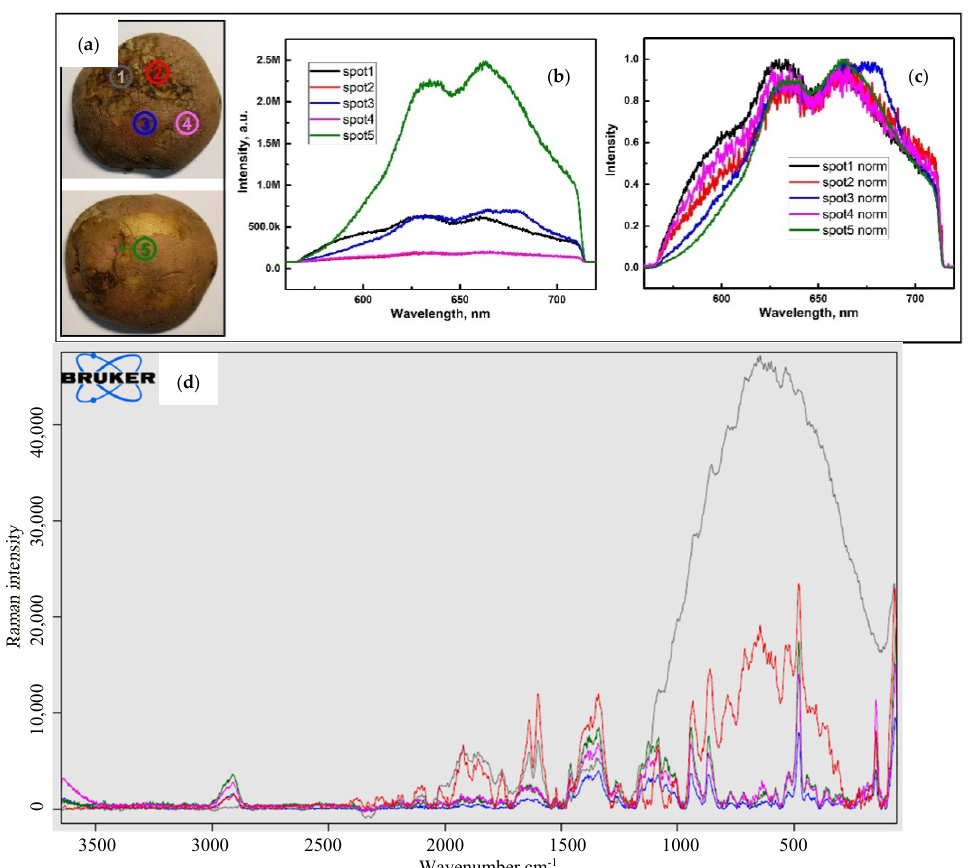
Figure 12. Example of sampling points of the marketable ( a ) (left and above fluorescence spectra ( image above-b , c ) and RAMAN spectra ( image below - d ) of the different damaged parts (1-2—highly damaged, 3-4—thicker and thinner parts of the skin correspondently, 5—eyehole) of the potato tuber of the Zhukovsky variety. Points 1 and 2 are from the rotting part of the skin. Point 3 corresponds to the thicker part of the skin, and point 4 to the thinner part. Point 5 corresponds to the eyehole of the potato tuber. The spectra are different for different